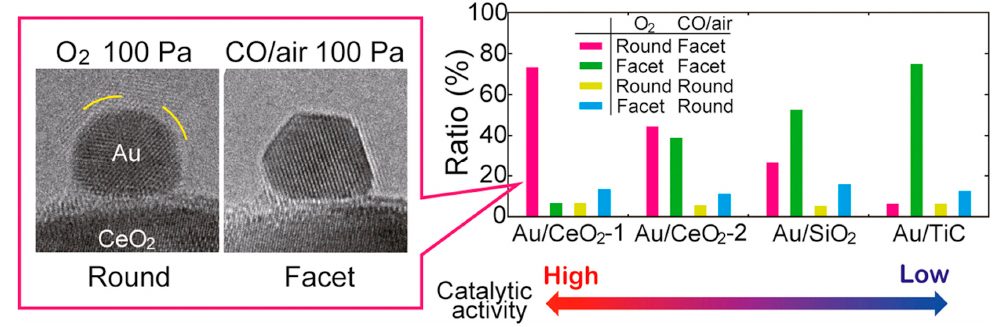
Figure 23. Correlation of the catalytic activity of supported Au catalysts with the “morphology-changeable” character of the nanoparticles, which is directly influenced by the nature of the support. Reproduced from [260]. Copyright 2017, Elsevier.